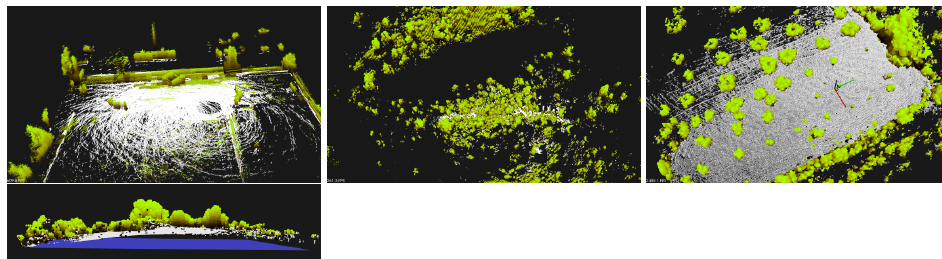
Figure 20. Segmented 3D maps (40 m × 40 m) into ground and non-ground data. Scenarios A ( left ), B ( center ), and C ( right ). Bottom picture shows side view from scenario C. Scale: axes are 5 m